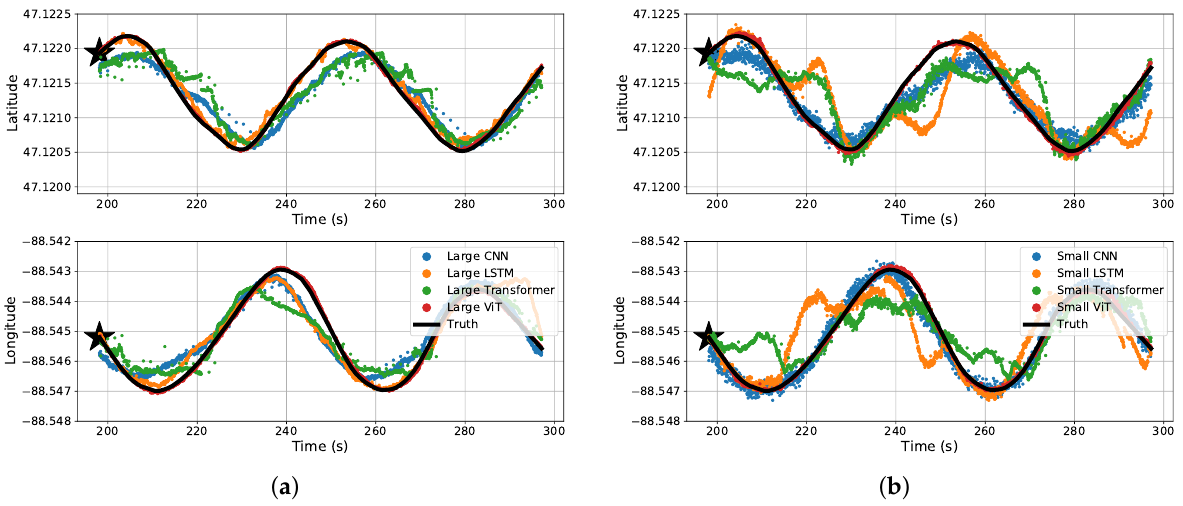
Figure 11. Time-series split predicted results for the four different ( a ) large regression algorithms and ( b ) small regression algorithms.